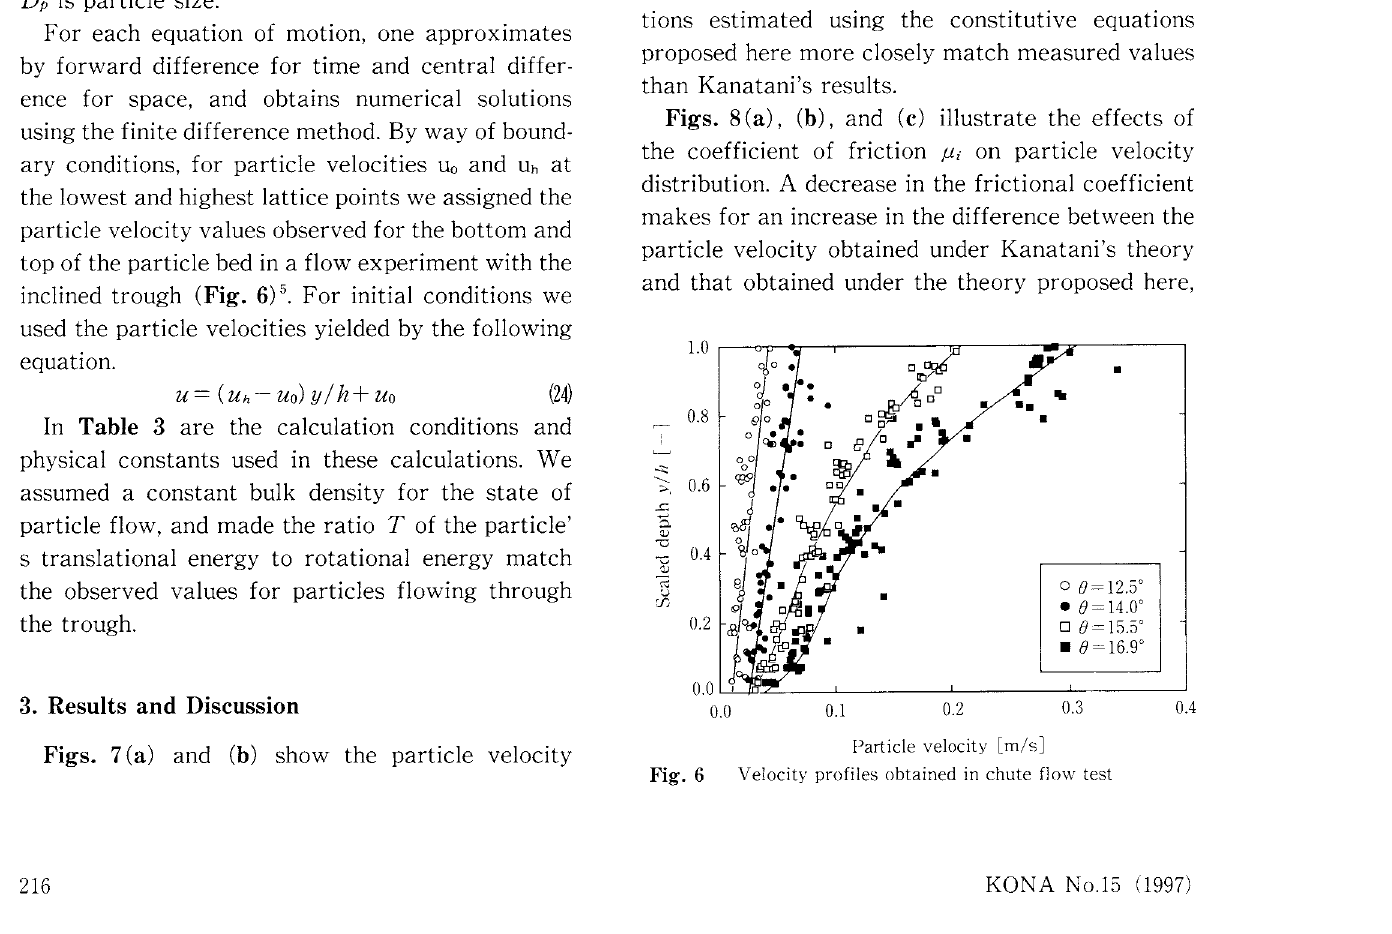
Fig. 6 Velocity profiles obtained in chute flow test